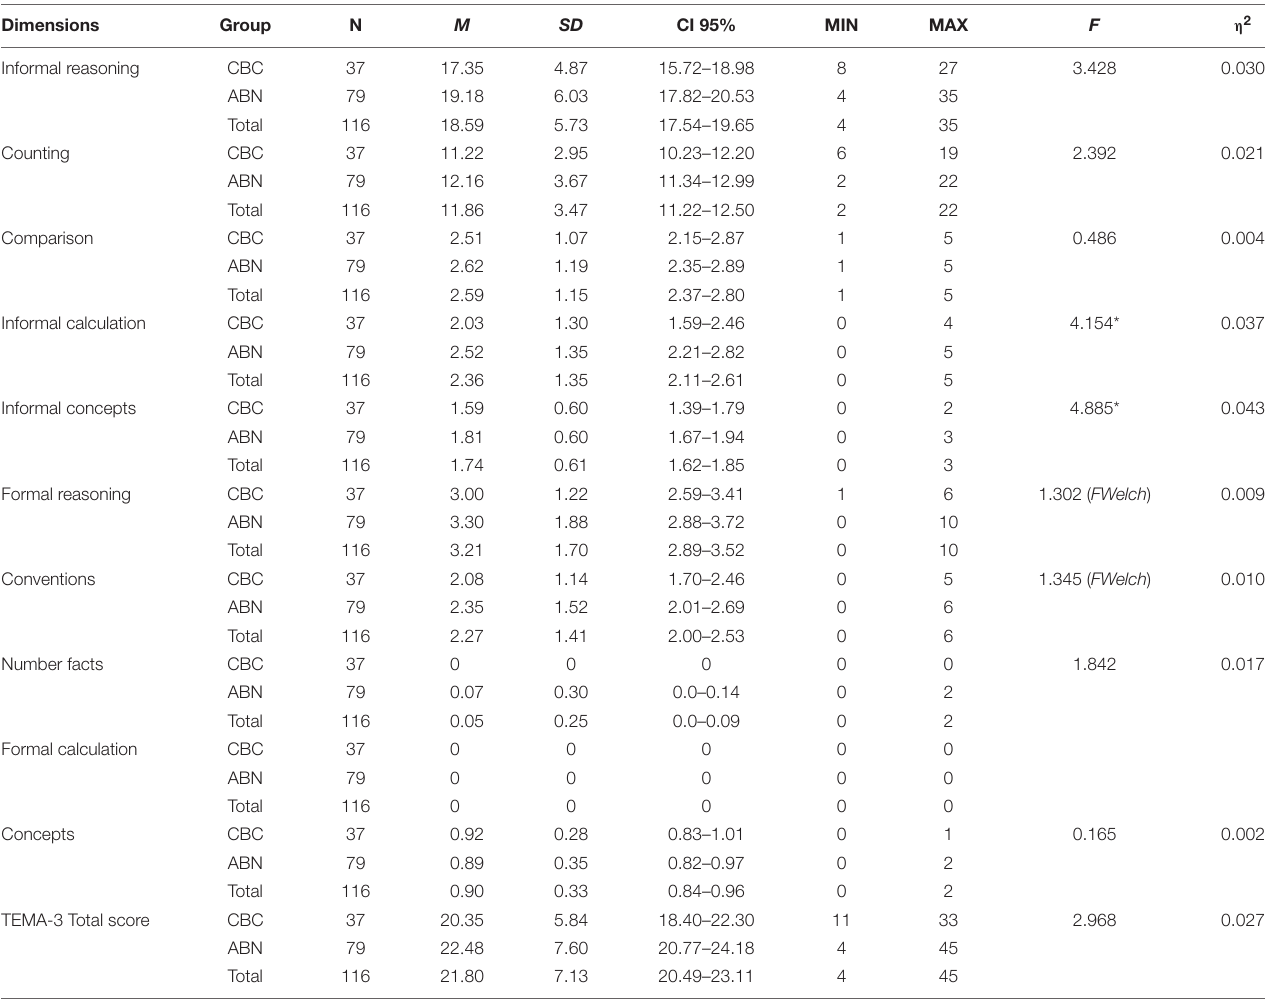
TABLE 2 | Descriptive statistics for the different TEMA-3 test dimensions for the 4-year-old CBC and ABN groups.